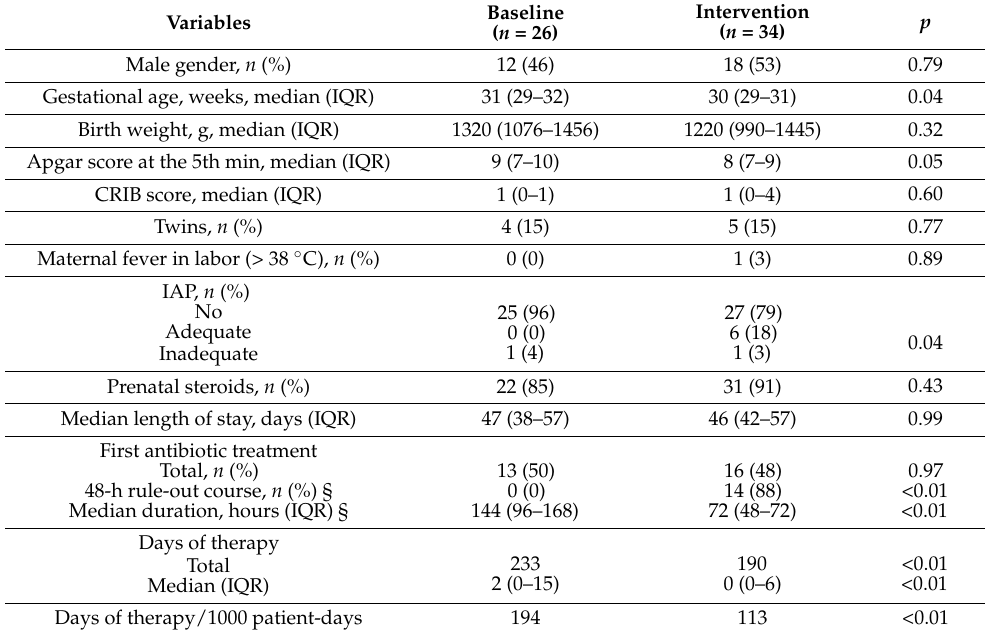
Table 3. Neonates with a low risk of early-onset sepsis and antibiotic treatments at baseline and in the intervention period.